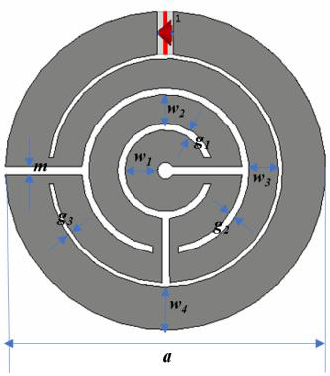
Table 2. Final dimensions of the proposed split-ring loop.